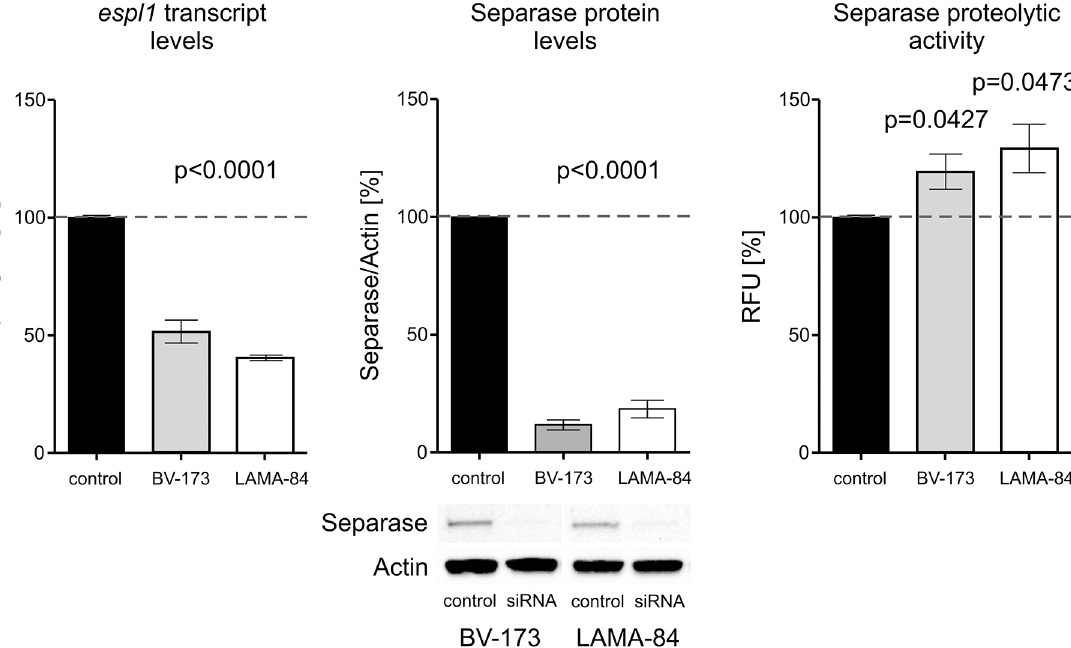
Fig 3. Separase expression and proteolytic activity after espl1 silencing by RNAi. BV-173 (b2a2) and LAMA-84 (b3a2) cells were treated with negative control siRNA (control) and espl1-specific siRNA (siRNA) for 48h. Consecutively, Separase expression was analysed on transcript level (qRT-PCR), protein level (Western blot immunostaining) and proteolytic activity level (fluorometric assay). All protein analyses were performed as described in legend to Fig 1. In qRT-PCR analysis the house-keeping gene gus (beta-glucuronidase) served as internal standard. Abbreviations: RFU, relative fluorescence units. As for interpretation, 11.7% of Separase protein (middle panel, p < 0.0001) performs 118.5% proteolytic activity in BV-173 cells (right panel, p = 0.0427) corresponding to an about 10fold posttranslational activation of present Separase molecules (118.5%/11.7% =